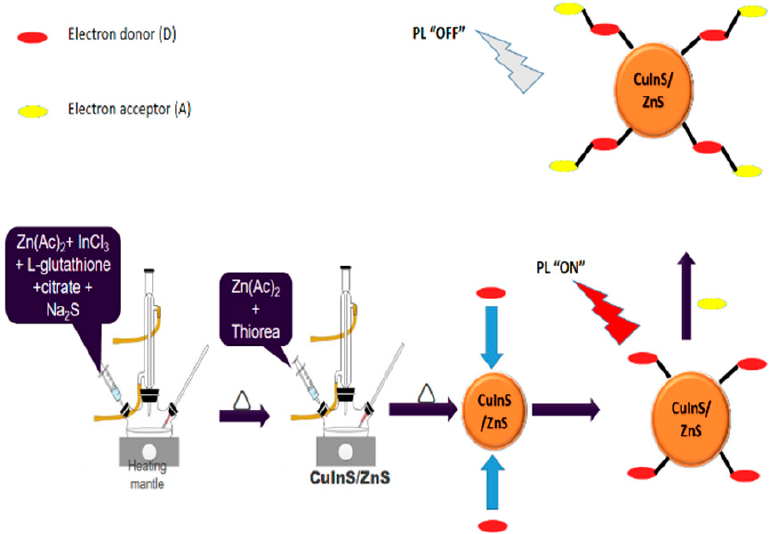
Scheme 2. Fluorescence detection of different nitroaromatic compounds by surface-modified QDs.